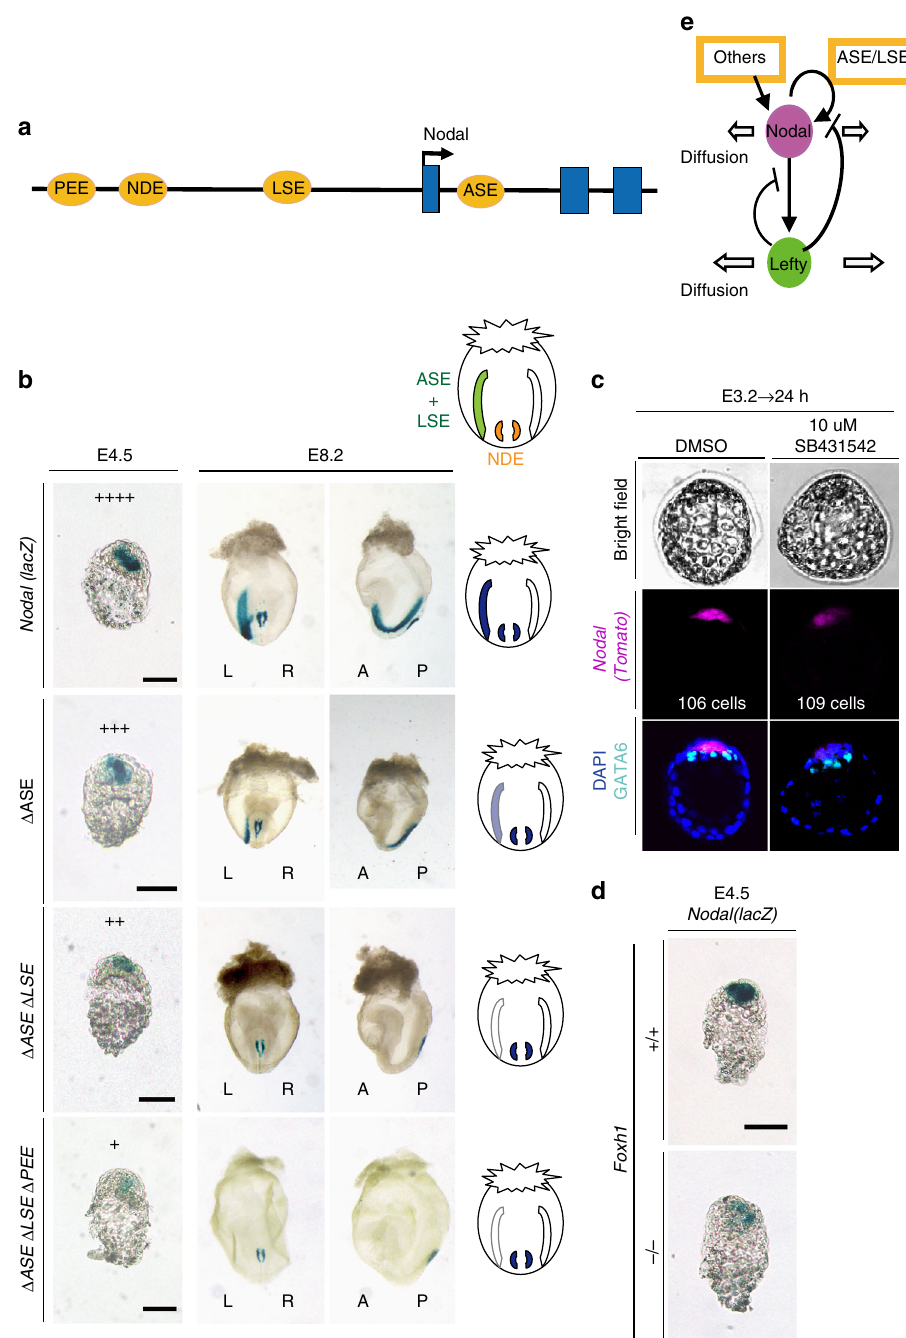
Fig. 5 Regulation of Nodal expression in peri-implantation embryos. a Four transcriptional enhancers — ASE, LSE, NDE, and PEE — contribute to regulation of Nodal expression. b Expression of Nodal(lacZ) BAC transgenes containing all enhancers or lacking either ASE alone, ASE and LSE, or ASE, LSE, and PEE was determined in embryos at E4.5 and E8.2 by X-gal staining. Scale bars, 50 μ m. In E4.5 embryos, the relative levels of Nodal expression in the different embryos are indicated by plus signs. Frontal and lateral views are shown for E8.2 embryos. X-gal + regions are schematically summarized in diagrams on the right. Note that ASE and LSE are active in the lateral plate mesoderm, whereas NDE is active in the node 40 . c E3.2 embryos harboring a Nodal(Tomato) BAC transgene were cultured for 24 h with 10 µ M SB431542 or dimethyl sulfoxide (DMSO) vehicle and were then examined for Tomato and GATA6 immuno fl uorescence. d Expression of the Nodal(lacZ) BAC transgene in Foxh1 + / + and Foxh1 – / – embryos at E4.5. Scale bars, 50 µ m. e Regulatory relation between Nodal and Lefty at the peri-implantation stage. The genes constitute a SELI system, as they do for L – R patterning at